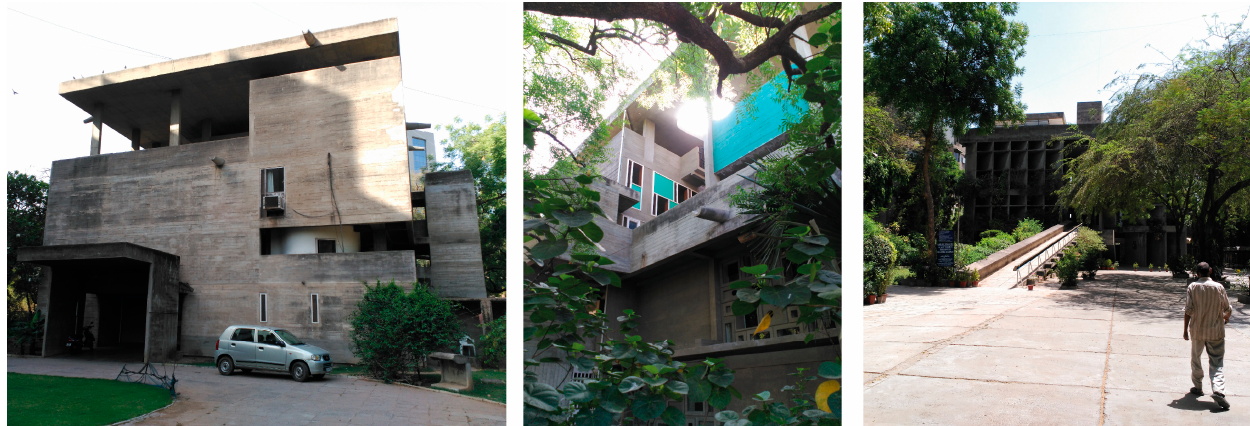
Figure 3. Villa Schodhan ( left and centre ) and Millowner’s Association Building ( right ), both built in 1951 in Ahmedabad (India) and both in use but not protected. Source: Authors.